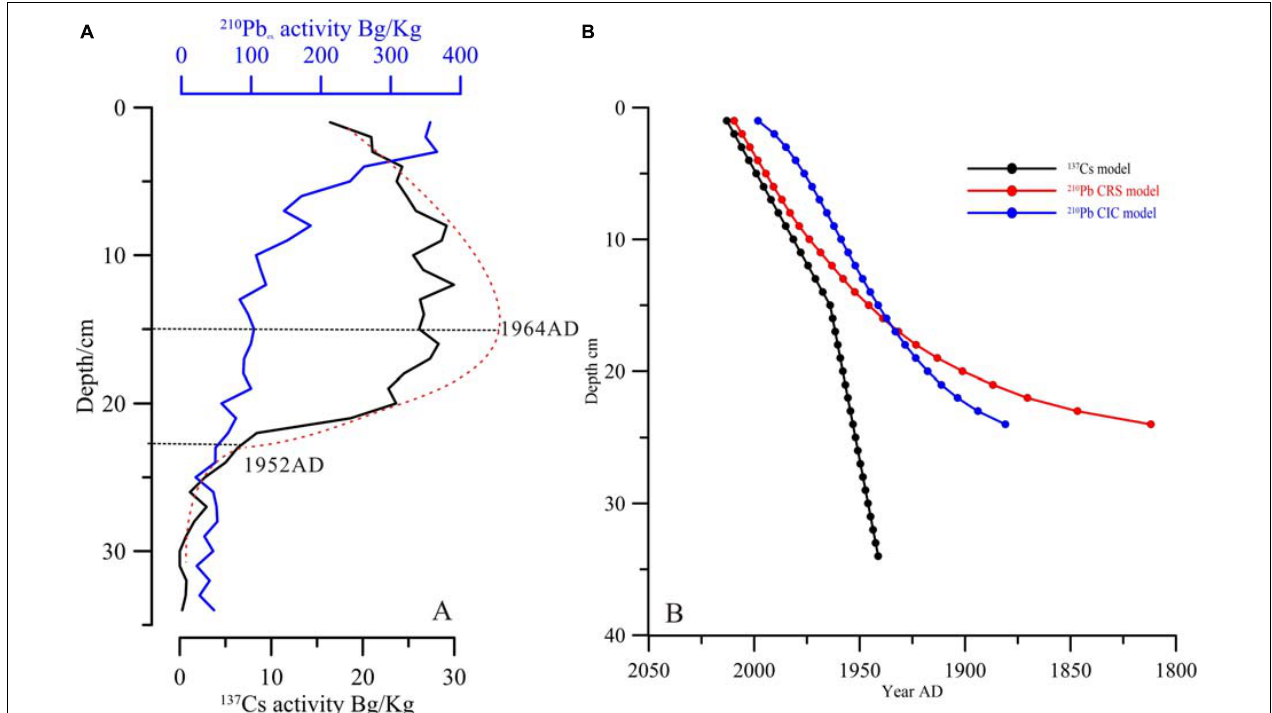
FIGURE 2 | (A) 137 Cs and 210 Pb activity of the surface sediments in core BL13-1-4. (B) 137 Cs and 210 Pb age models (see text for details).